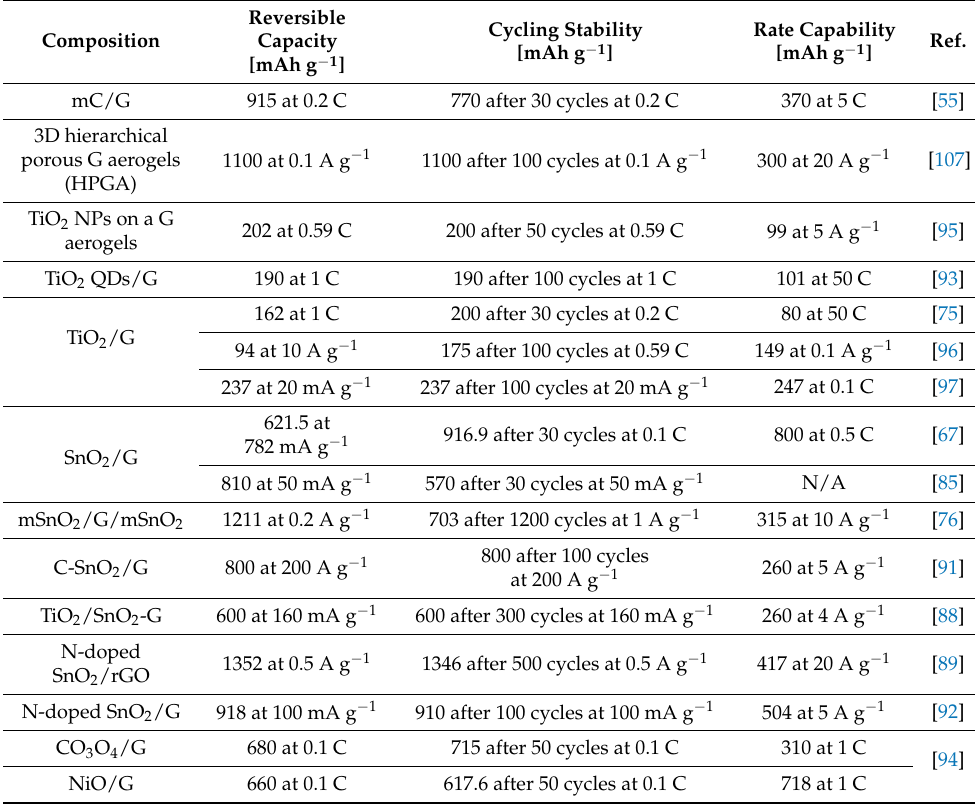
Table 3. The G-based 2D mesoporous materials for lithium-ion battery (LIB)